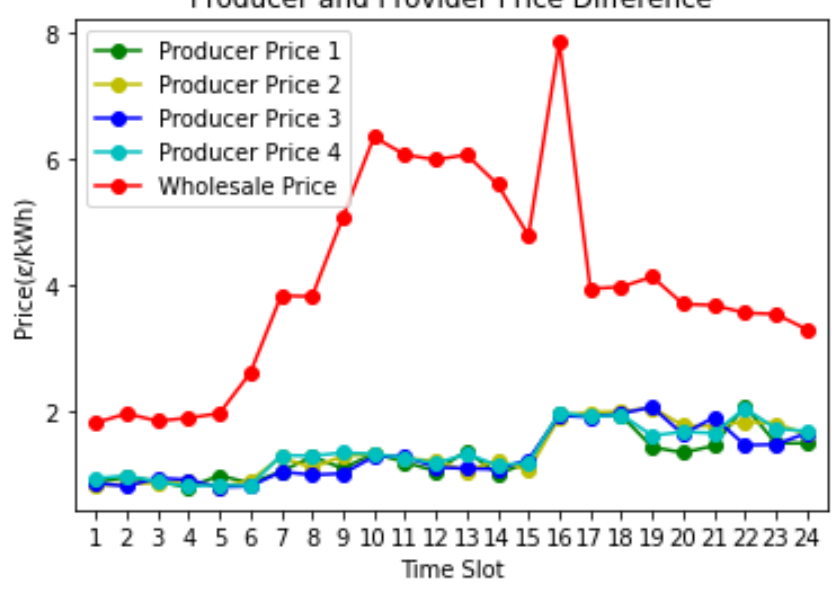
Figure 9. Different prices of producer and provider.